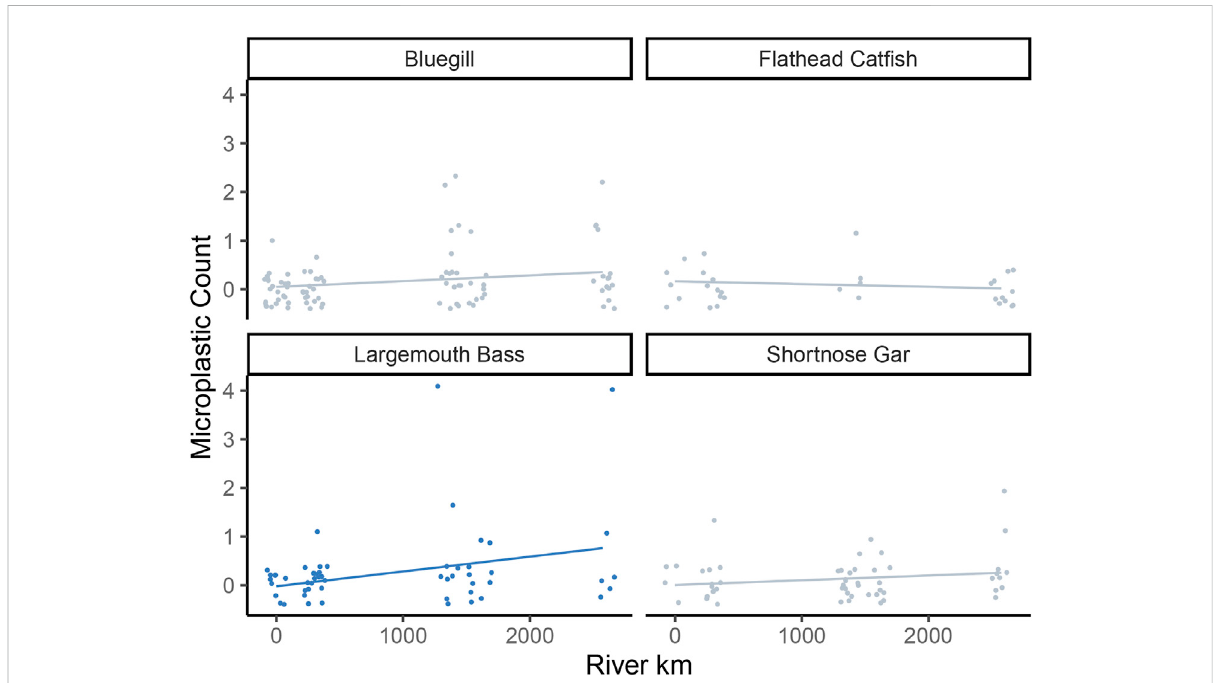
FIGURE 4 Scatterplots by species of microplastic counts per individual fi sh regressed against river location (km; with 0 km representing the farthest upstream location and points jittered to prevent overlap). Regression lines represent the zero-in fl ated Poisson model fi t, with gray intervals representing model uncertainty. Gray points and lines indicate species with non-signi fi cant model fi ts, while blue points and lines represent signi fi cant model fi